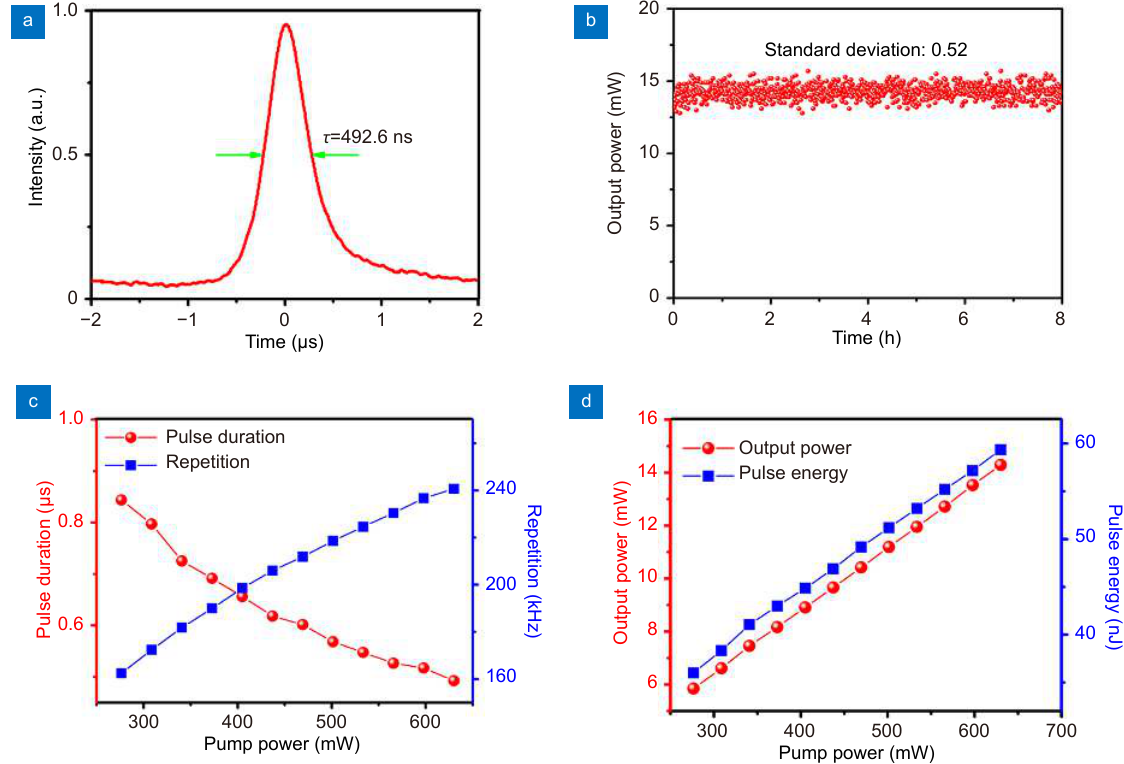
Fig. 4 | The performance of the QSFL based on 7.7 nm-SnS 2 SA. ( a ) The τ of a single pulse. ( b ) The monitoring of P out within 8 hours. ( c ) Variation of τ and F rep as functions of P pump . ( d ) Variation of P out and E p as functions of P pump .